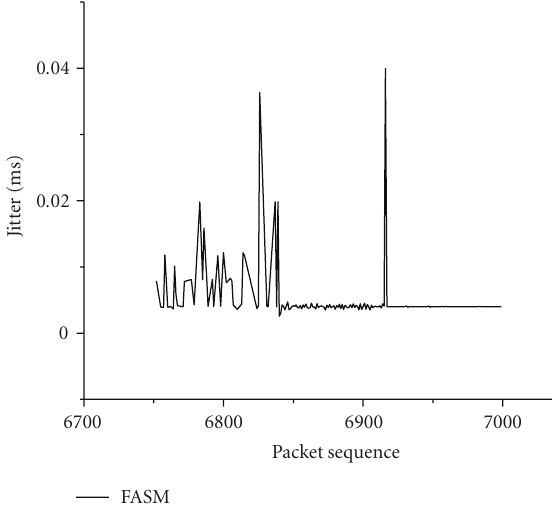
Figure 10: Jitter in FASM with error